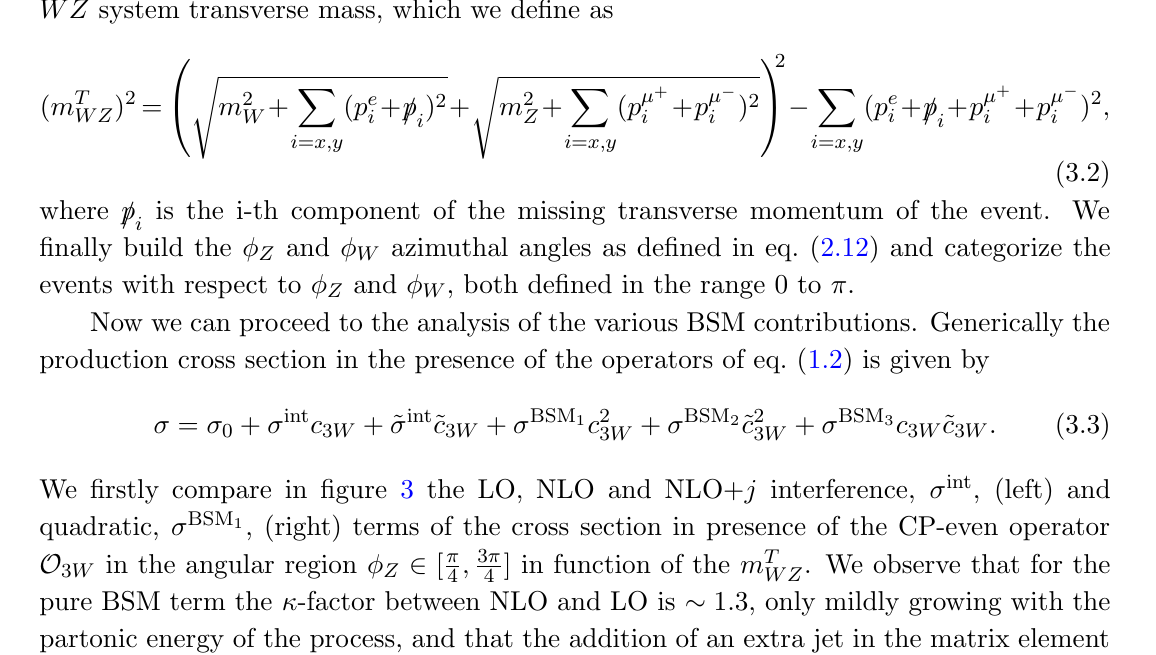
applying a (cid:12)nal combinatorial factor to take into account all possibile (cid:12)nal state (cid:13)avor con(cid:12)gurations involving the (cid:12)rst two generation lepton (cid:13)avor. We generate events